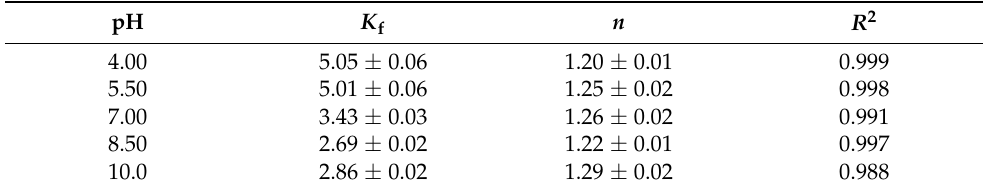
Table 4. Freundlich model parameters of 2,3,7,8-TCDT in sediments from the eastern part of Chaohu Lake at different pH